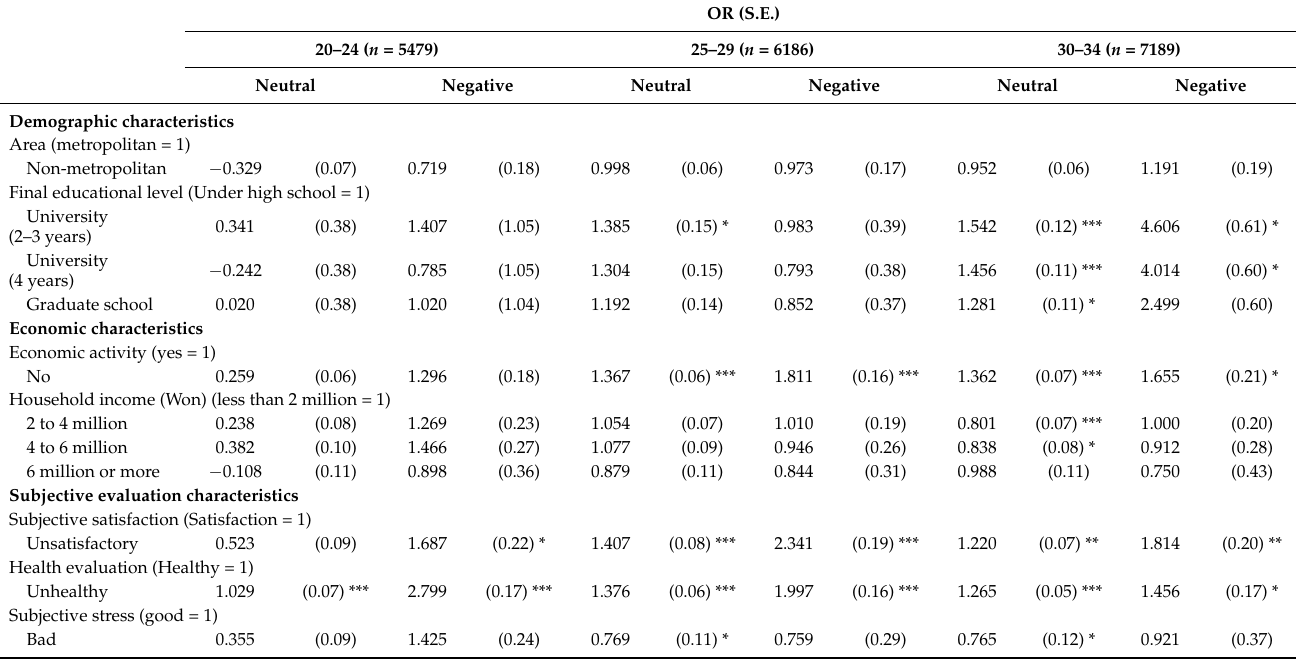
Table 2. Factors affecting marriage intentions of unmarried men (aged 20–34) 1